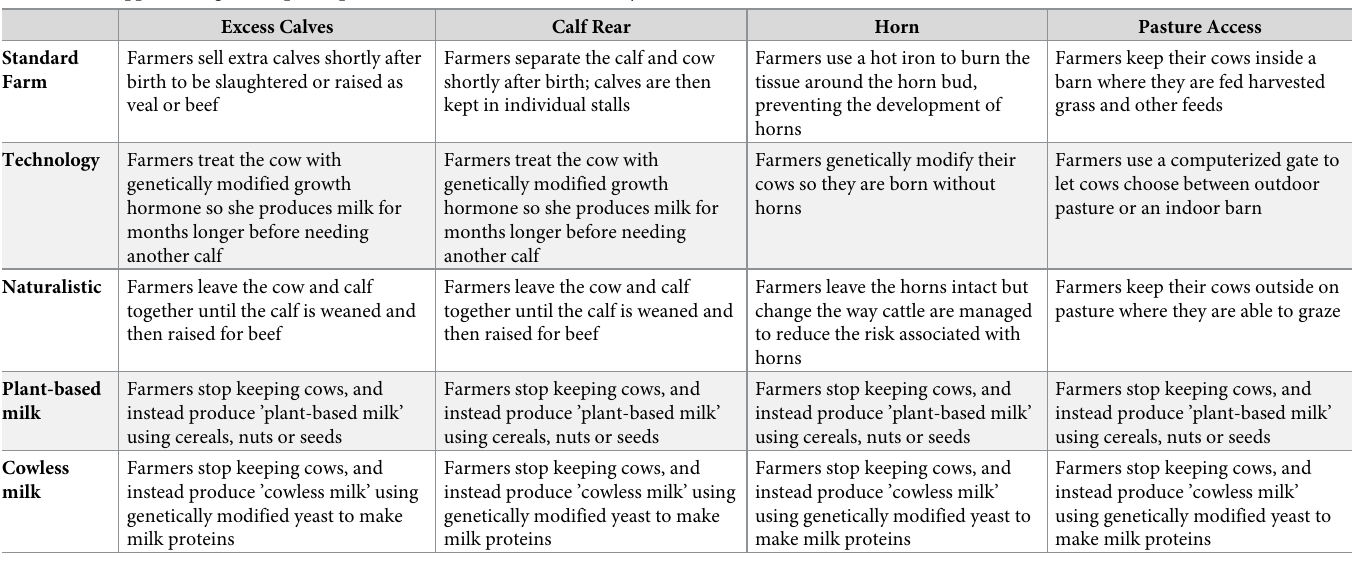
Table 3. Five approaches given to participants for each scenario of the